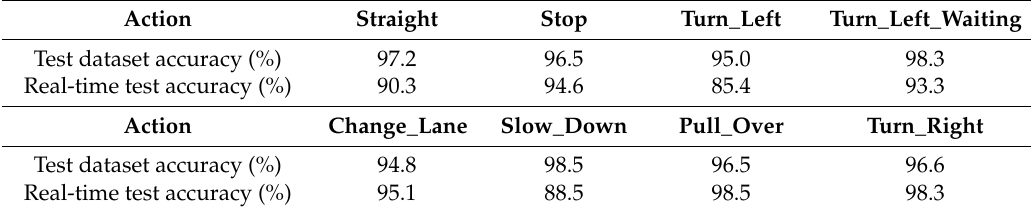
Table 2. Test results of the ST-CNN model.